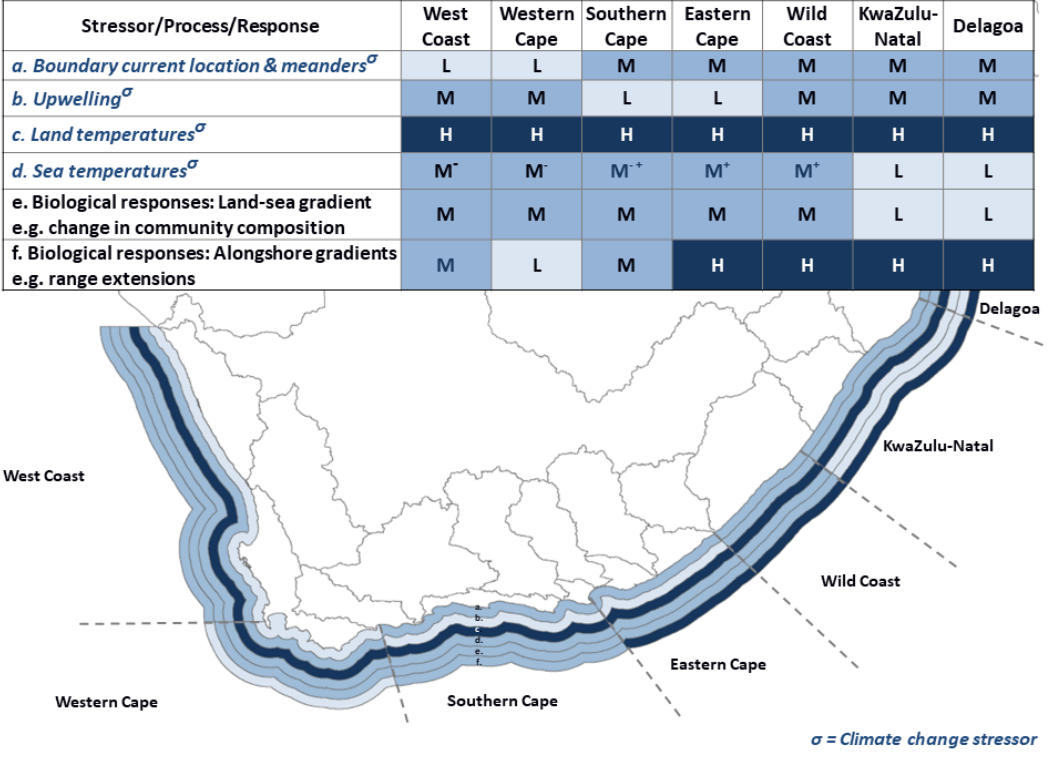
Figure 3. Summary of vulnerability rating (high/medium/low) for estuaries in seven regions, associated with changing ocean circulation, focusing on temperature regimes (colour zones on map depict ( a ) to ( f ) in table moving outward from the coast with H = high, M = medium, L = low).